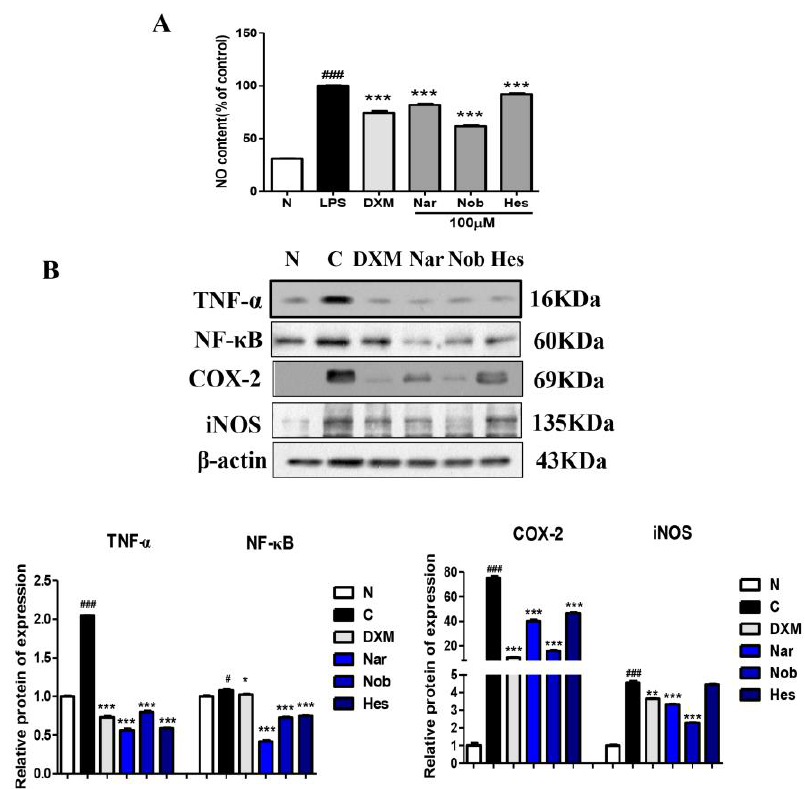
Figure 6. Inhibitory effects of naringenin, nobiletin, and hesperetin on pro-inflammatory cytokine production in lipopolysaccharide (LPS)-induced RAW264.7 cells. ( A ) NO content in the supernatant of RAW264.7 cells. ( B ) The protein expressions of pro-inflammatory cytokines in LPS-induced RAW264.7 cells. N: normal group; C: LPS only group (0.5 µ g/mL); DXM: dexamethasone 1 µ g/mL + LPS (0.5 µ g/mL); Nar: naringenin (100 µ M) + LPS (0.5 µ g/mL); Nob: nobiletin (100 µ M) + LPS (0.5 µ g/mL); Hes: hesperetin (100 µ M) + LPS (0.5 µ g/mL); n = 6, # p < 0.05, ### p < 0.001 vs. normal group; * p < 0.05, ** p < 0.01, *** p < 0.001 vs. LPS group. Data (mean ± SEM) were analyzed by ANOVA.